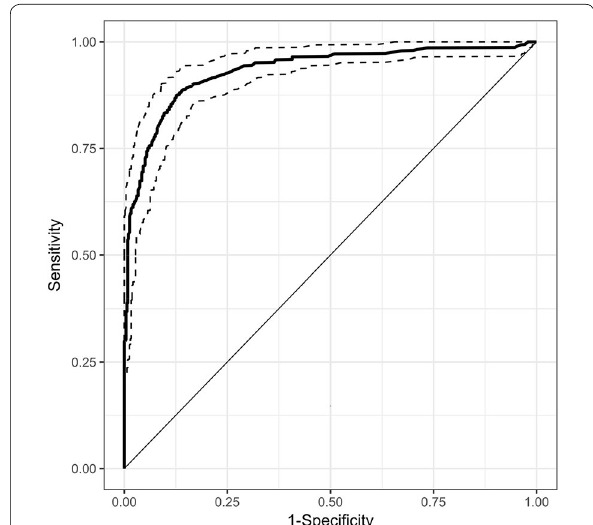
Fig. 3 ROC curve for SpO 2 /FiO 2 versus PaO 2 /FiO 2 < 100. Dotted lines represent 95% confident intervals, AUC curve